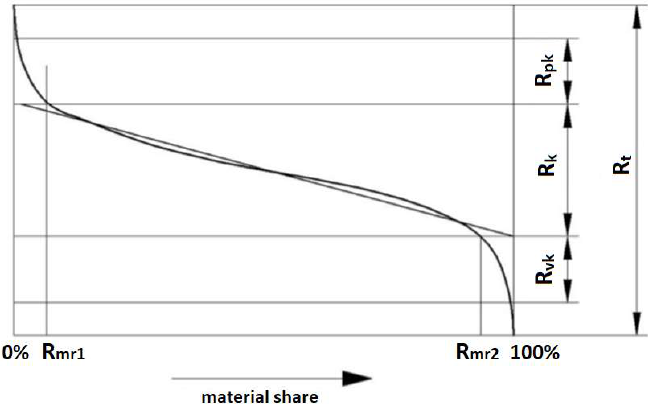
Figure 3. Rough material profile curve and its parameters.